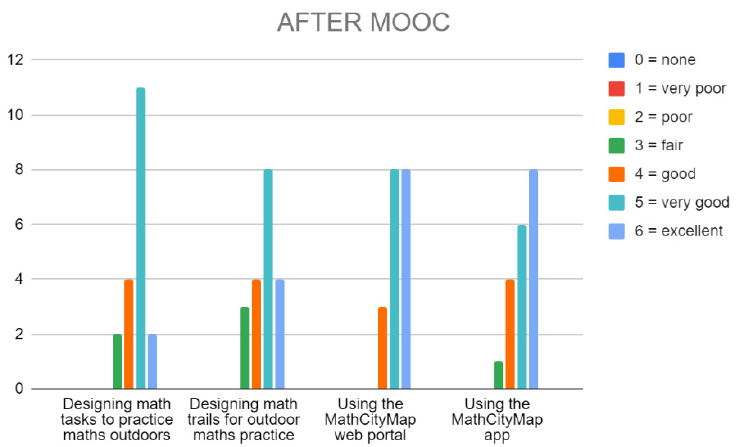
Figure 14. Teachers’ awareness of their skills after the